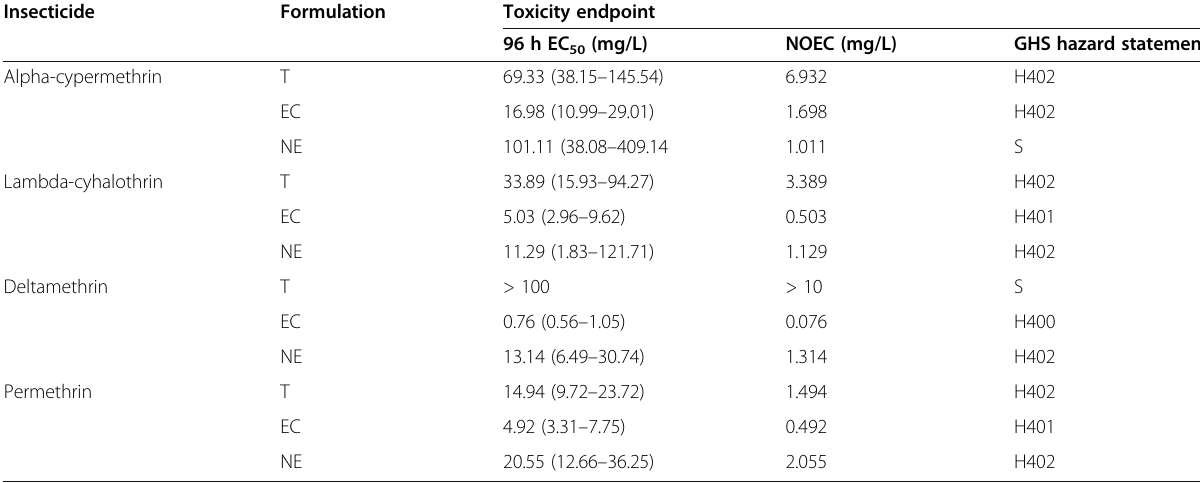
Table 7 EC 50 and NOEC (mg/L) of nanoformulations compared with technical and commercial formulated pyrethroids to freshwater microalga R. subcapitata . The 95% confidence limits of the EC 50 values are indicated in